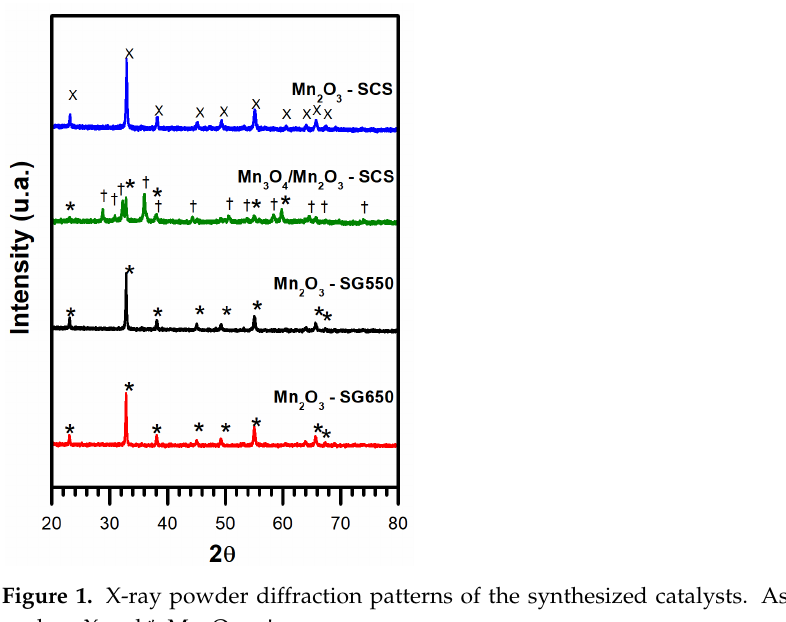
(ref. code 01-073-1826). The Mn 3 O 4 /Mn 2 O 3 catalyst showed a mixed diffraction